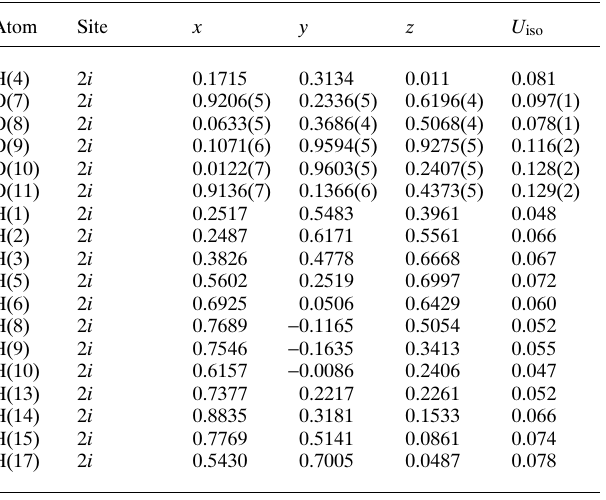
Table 2. Atomic coordinates and displacement parameters (in Å 2 )